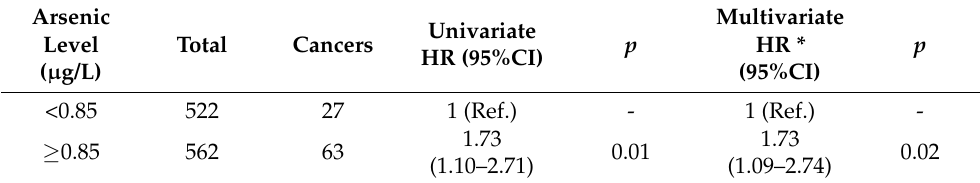
Table 4. Hazard ratios (HR) for any cancer stratified by median total blood arsenic level (µg/L) = 1084.